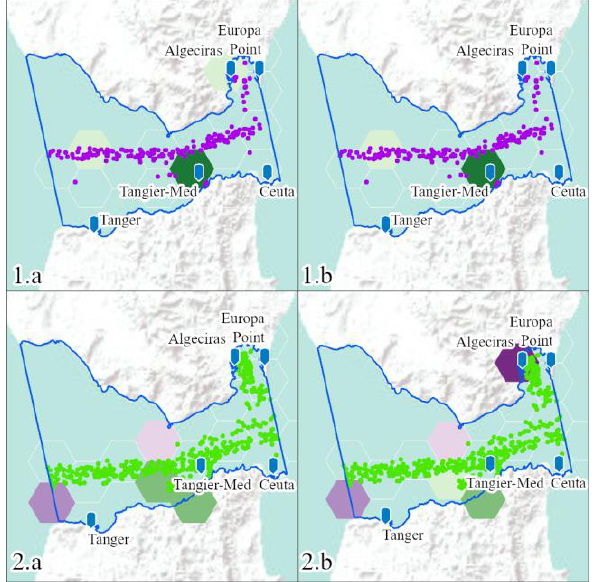
Figure 16 Trend analysis on counted AIS’ positions (a) and means TEUs over all bin locations, for the Strait of Gibraltar chokepoint, and directed to western and northern European ports (1) or to Mediterranean (2). (Basemap sources: Esri, USGS, NOAA).